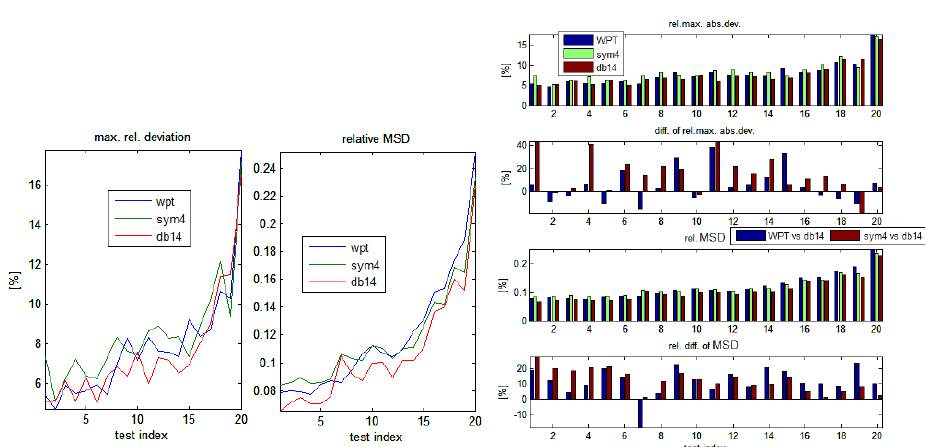
Figure 13. Maximum absolute relative error (left) and relative root mean square deviation (right).